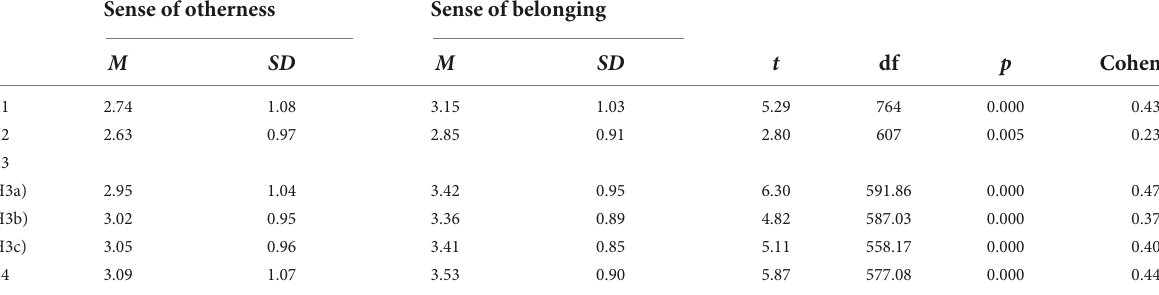
TABLE 3 Mean comparison of sense of otherness and sense of belonging on perceived diversity works. Sense of otherness Sense of belonging M SD M